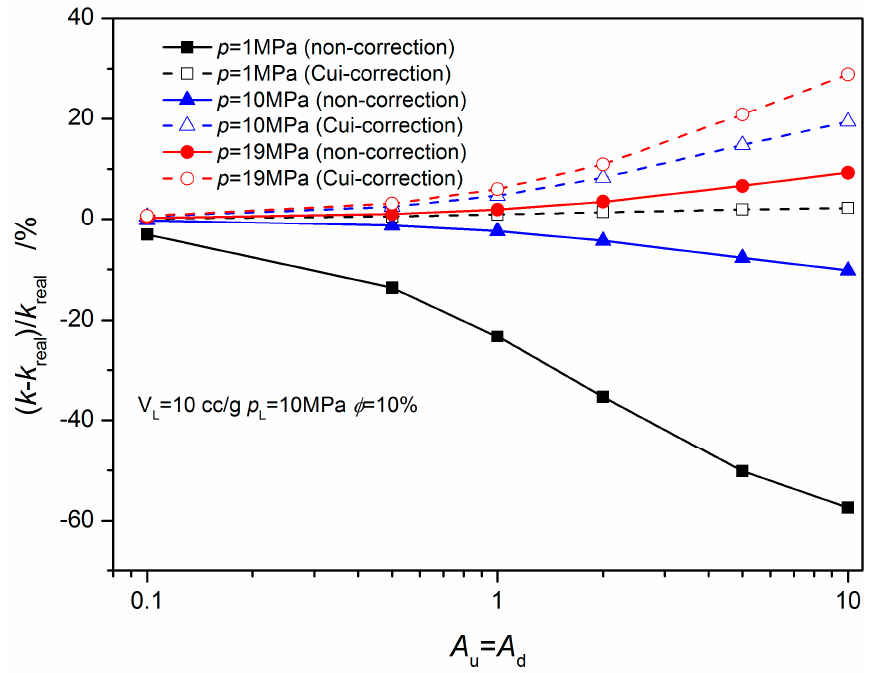
Figure 15. The influence of vessel volumes on the tested permeability. Energies 2019 , 12 , x FOR PEER REVIEW